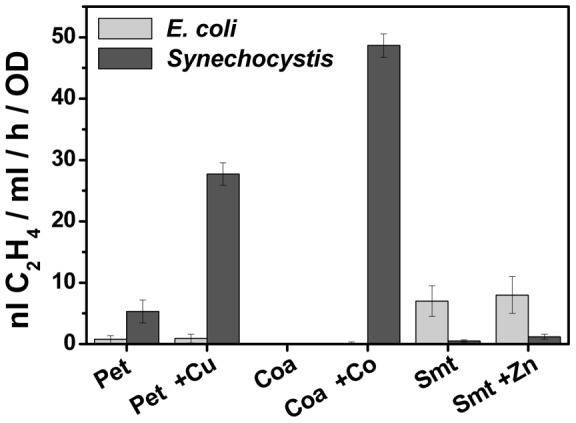
The rate of ethylene synthesis in E. coli and Synechocystis using three different metal-inducible promoters from cyanobacteria.The rate of ethylene synthesis was analyzed in cultures of E. coli (light grey bars) and Synechocystis (dark grey bars) carrying the metal-inducible plasmids pDF-pet-EFEh (PpetE), pDF-coa-EFEh (Pcoa) and pDF-smt-EFEh (Psmt). Cyanobaterial cultures were grown in BG-11 medium, lacking copper or cobalt for the evaluation of PpetE and Pcoa, respectively. E. coli cells were grown in LB medium. The ethylene concentration was measured in closed vials that were either not induced (no addition) or induced using 0.5 µM of CuSO4 for cells harbouring pDF-pet-EFEh, 6 µM of CoCl2 for cells harbouring pDF-coa-EFEh, or 2 µM of ZnCl2 for cells harbouring pDF-smt-EFEh.